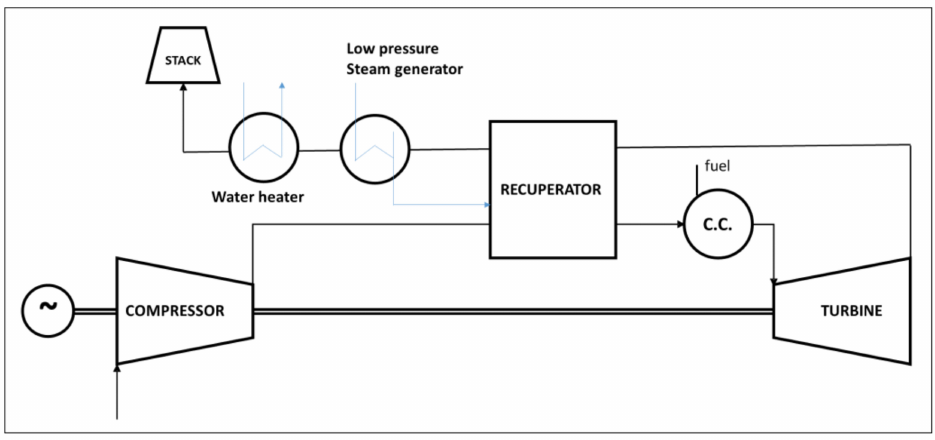
Figure 3. Steam Injection micro gas turbine (with injection before the recuperator) [31].